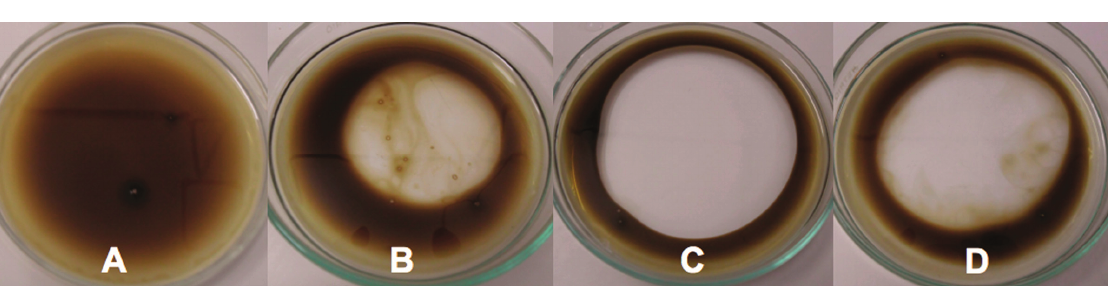
Figure 7. Oil displacement area formed according to substrates: ( A ) Burnt engine oil + distilled water; ( B ) Burnt engine oil + commercial detergent; ( C ) Burnt engine oil + Triton X-100 (1%); and ( D ) Burnt engine oil + isolated biosurfactant (1%) produced by Cunninghamella echinulata